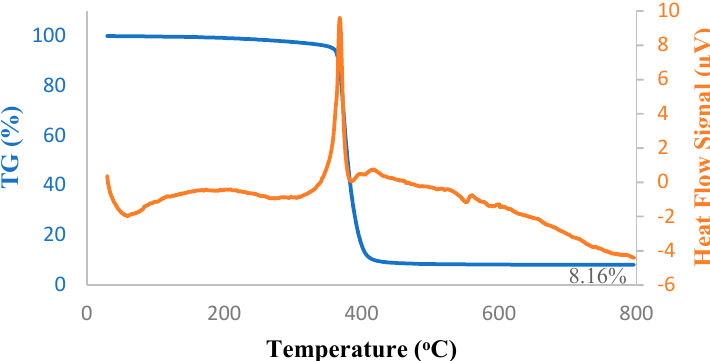
Figure 5. Thermogravimetry-differential scanning calorimetry (TG-DSC) thermograms of pure PTMSP membrane.